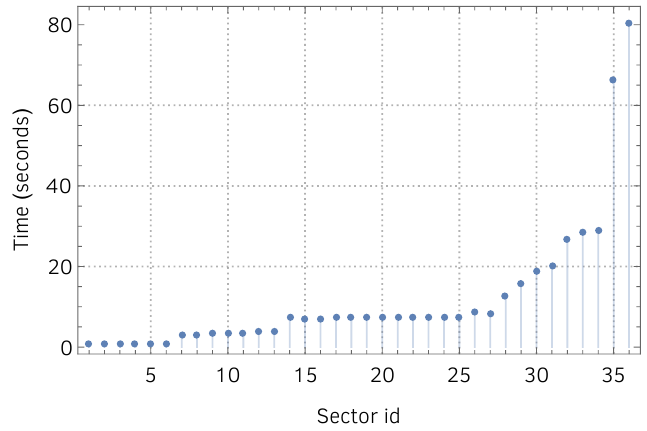
Figure 5 . Timings for the computation of the integrals up to and including a given sector at the point s 12 = 5 ; s 13 = (cid:0) 1 ; p 2 = 13 ; m 2 = 1 up to and including order (cid:15) 4 , on 1 CPU core. The point 4 15 is reached by expanding along the contour (cid:13) thr de(cid:12)ned in section 4.1. The last two values on the right of the plot correspond to the elliptic